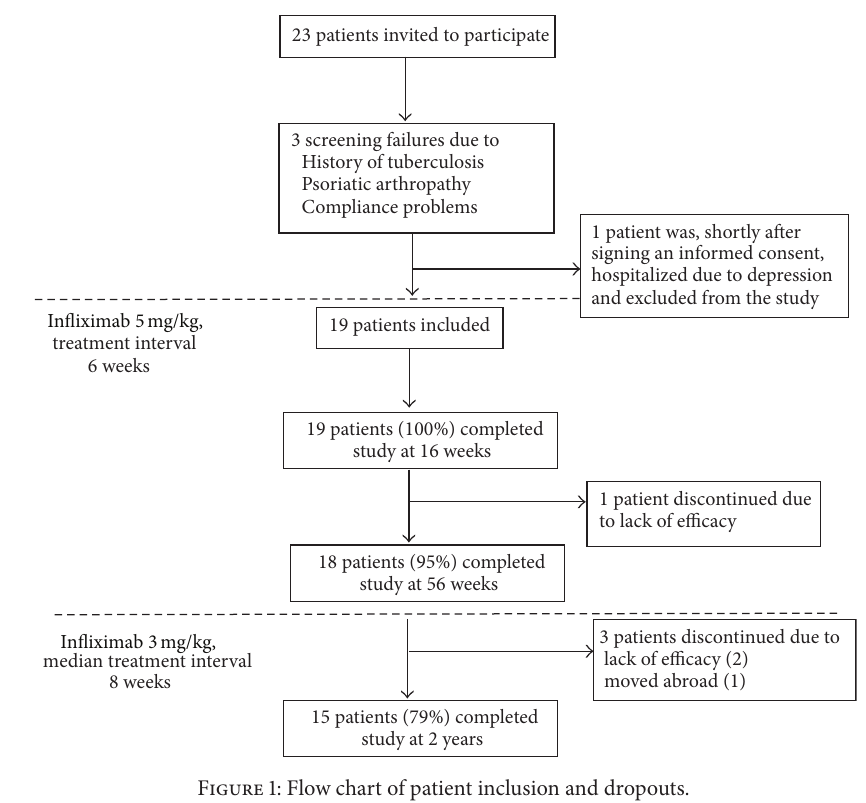
Figure 1: Flow chart of patient inclusion and dropouts.